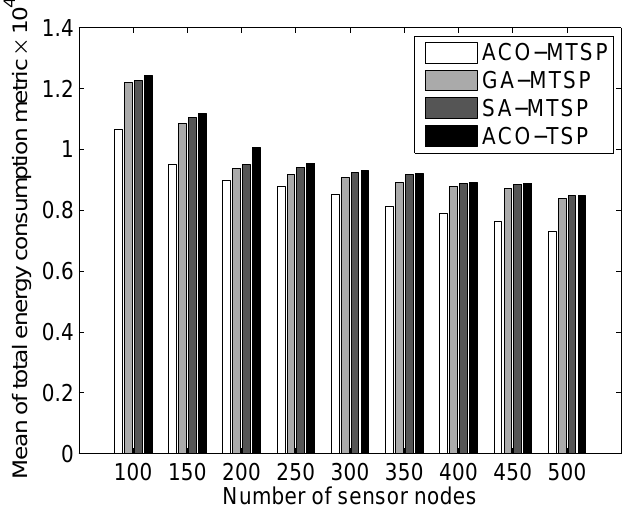
Figure 10. The mean of total energy consumption metric optimized by ACO-TSP, SA-MTSP, GA-MTSP and ACO-MTSP with the number of sensor nodes changing from 100 to 500, where the number of clusters is fixedly set to